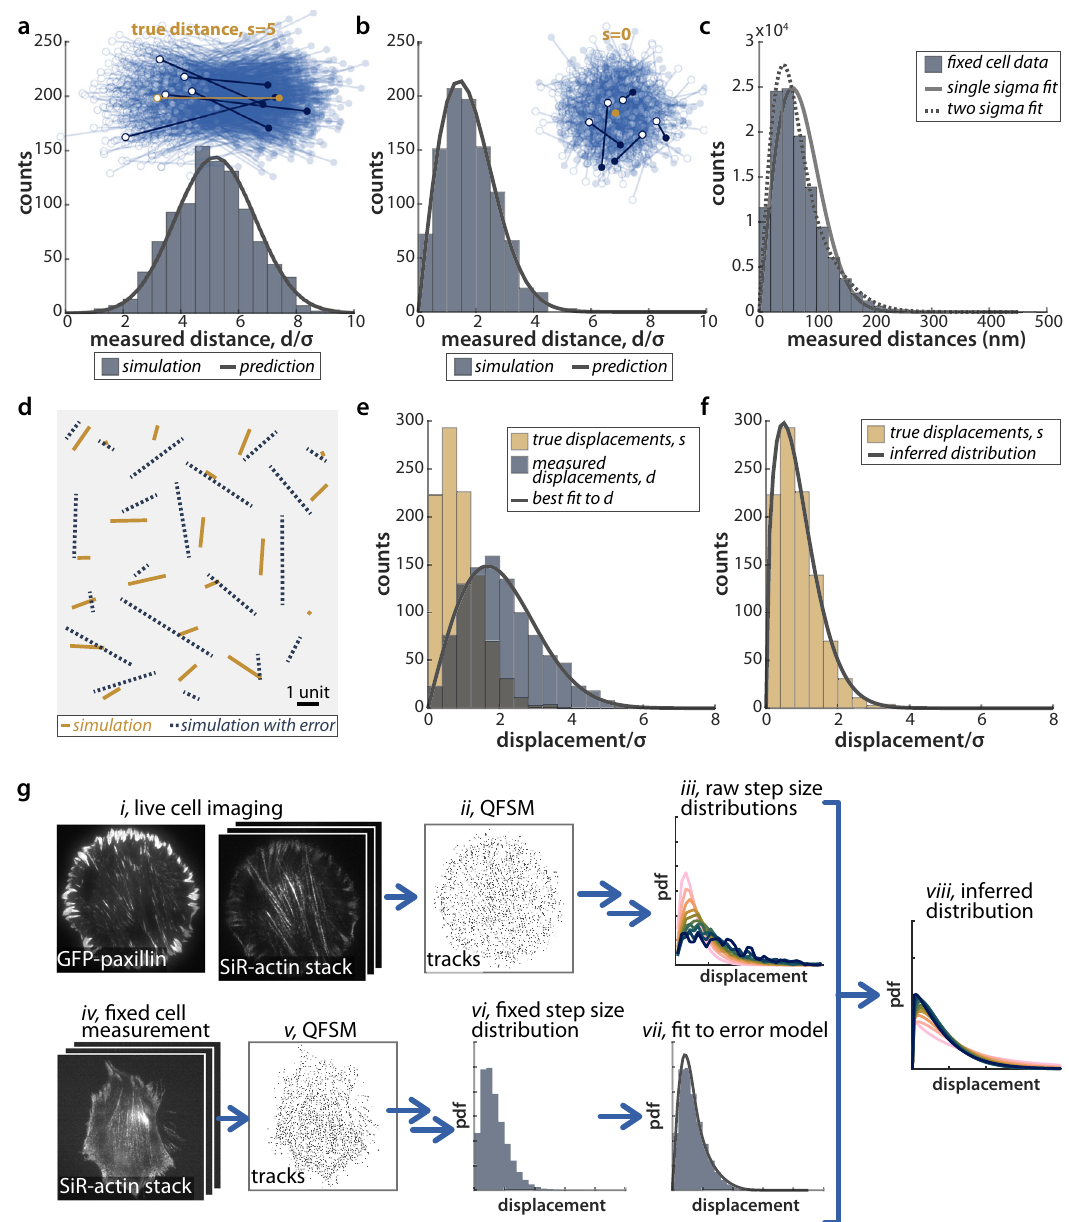
Fig. 2 Bayesian fi tting to reconstruct a distribution of true distances that are otherwise obfuscated by localization error. a , b Simulated pairs of points sampled around two true locations separeted by a distance s = 5 ( a ) or s = 0 ( b ), with localization error σ xy = 1. The fi rst point of each distance measurement is marked by an open circle, and the second point by a closed circle. Five representative pairs are shown in heavier weight. The histograms of measured distances and the predicted distribution of measured distances given by a noncentral χ are shown below. c The distribution of displacements measured in fi xed cells (measured over a 2 s increment) fi t to a noncentral χ distribution with s = 0, or the sum of two noncentral χ distributions, each with s = 0 and differing values of σ . n = 10 cells. d Simulated frame-to-frame motion of 20 simulated particles, showing both the true displacements, drawn from a Weibull distribution (shape = 1.5, scale = σ xy = 1) and the error-laden measured displacements. e The distribution of true distances and measured distances for 1000 such particles, as well as the best fi t to the measured distribution. f The resulting inferred true distribution from the fi t in e overlaid with the true distribution of distances. g This method is applied to measurements of SiR-actin in cells: i, iv. Images of both GFP-paxillin-marked adhesions and SiR-actin are acquired on a TIRF microscope. ii, v. QFSM 39 is used to identify puncta and tracks through time. iii, vi. Tracks are fi ltered and sub-pixel localized to generate a distribution of displacements across the cell. vii, viii. Using the fi xed cell data as a measure of the localization error, we can infer the true displacement distribution from live-cell measurements. Source data for a – f are provided in the Source Data fi